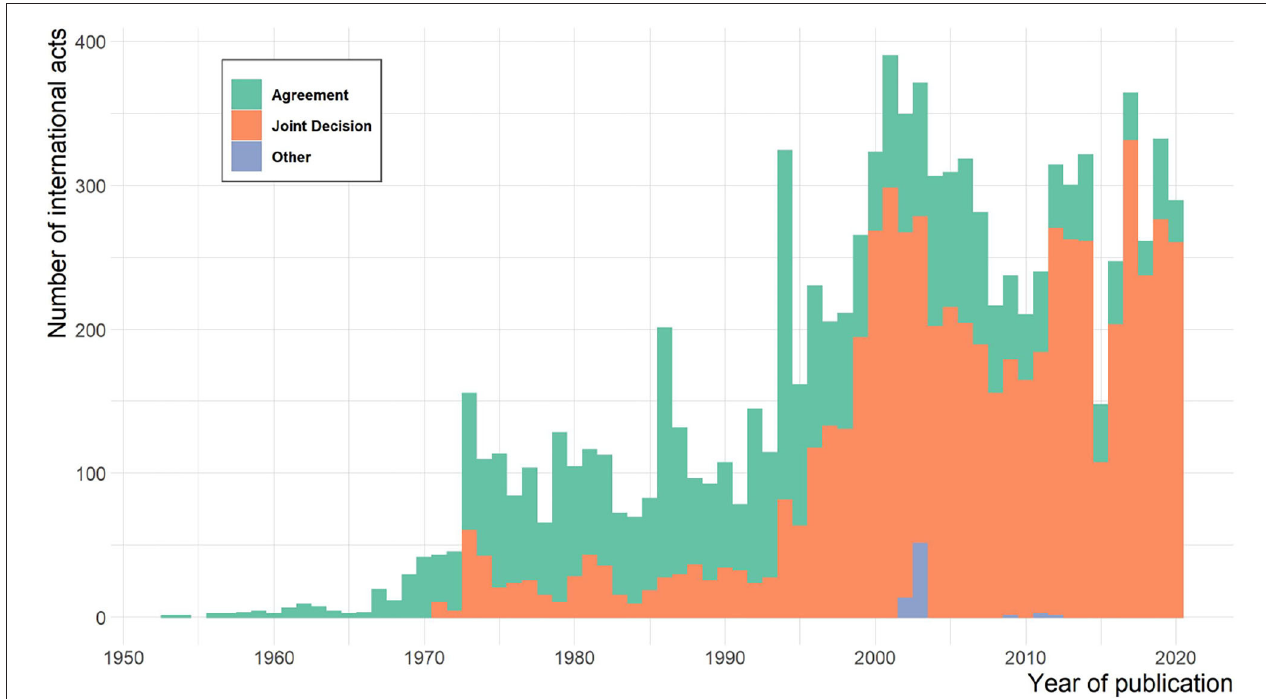
FIGURE 1 | Categories of international acts in the dataset